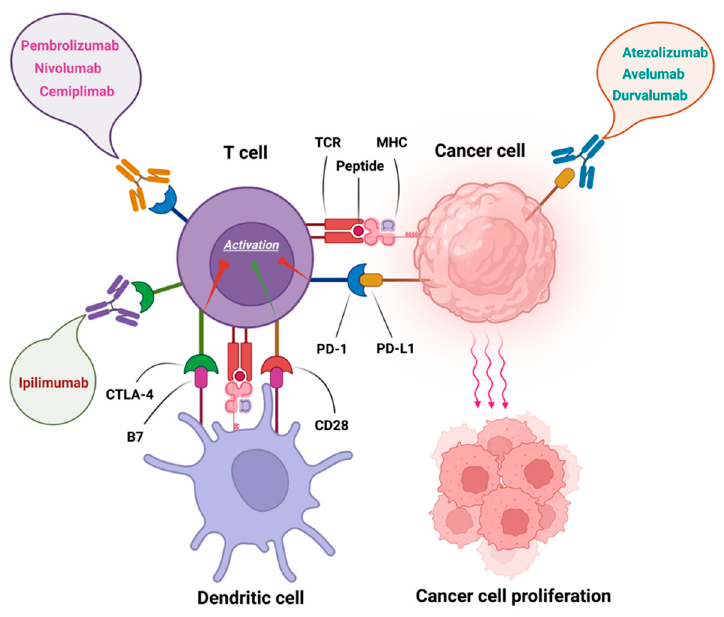
Figure 1. Immune checkpoint inhibitors approved by FDA. Pembrolizumab, Nivolumab, and Cemi- plimab as anti-PD-1 antibodies, Ipilimumab as an anti-CTLA-4 antibody, as well as Atezolizumab, Avelumab, and Durvalumab as anti-PD-L1 antibodies.